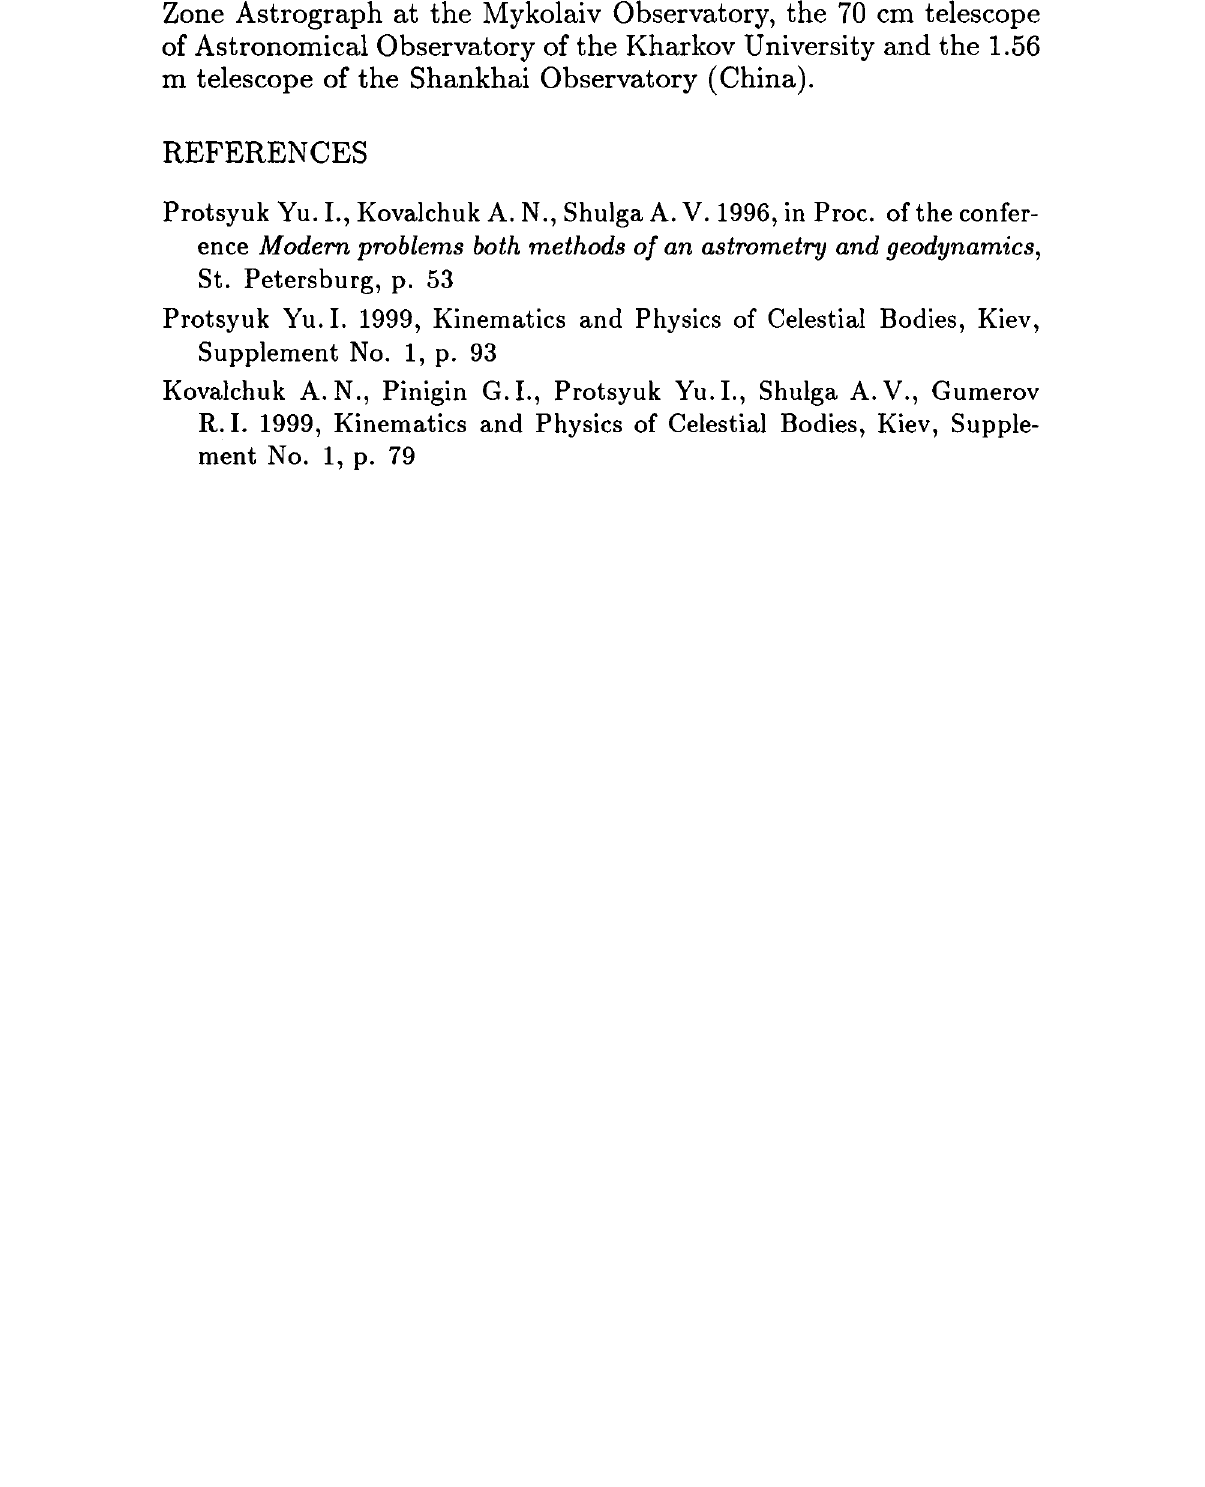
Zone Astrograph at the Mykolaiv Observatory, the 70 cm telescope of Astronomical Observatory of the Kharkov University and the 1.56 m telescope of the Shankhai Observatory